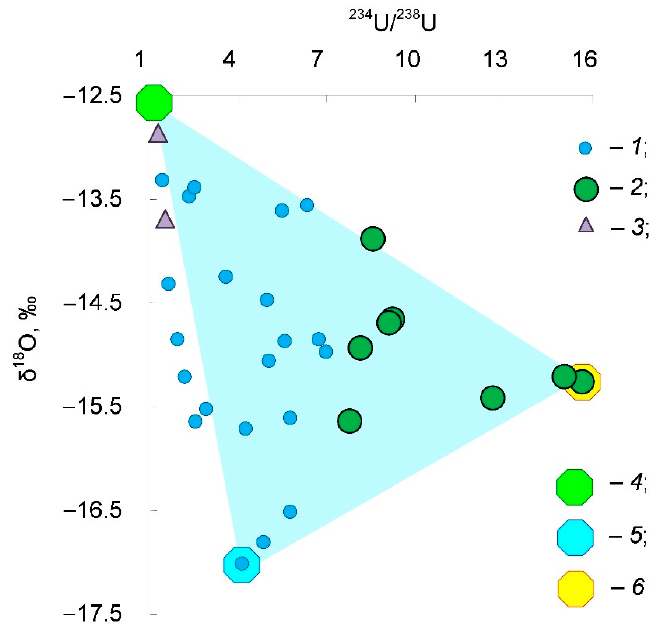
Figure 9. Comparison of the isotopic composition of uranium and oxygen-18 content in ground- water of the Pre-Volga region: 1 —points without anomalies of the isotopic composition of uranium ( 234 U/ 238 U < 7.8); 2 —points with anomalies of the uranium isotopic composition; 3 —outliers; and 4 , 5 , and 6 —mixing end-members “modern water”, “postglacial water” and “glacial meltwater”, respectively.